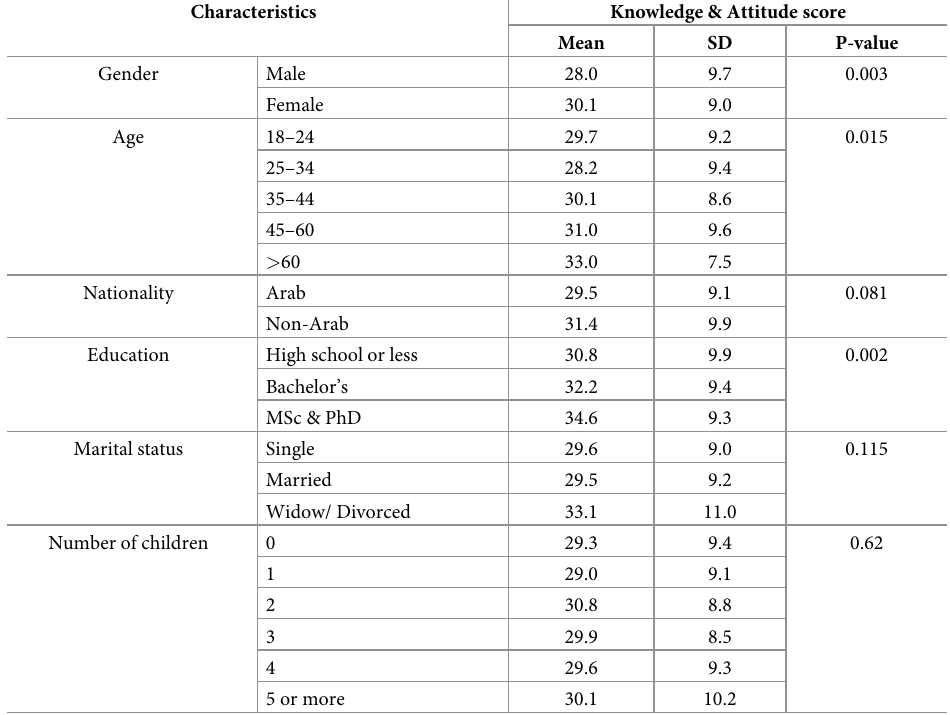
Table 2. Association of sociodemographic variables with knowledge and attitude of respondents regarding food additives (n = 1038).